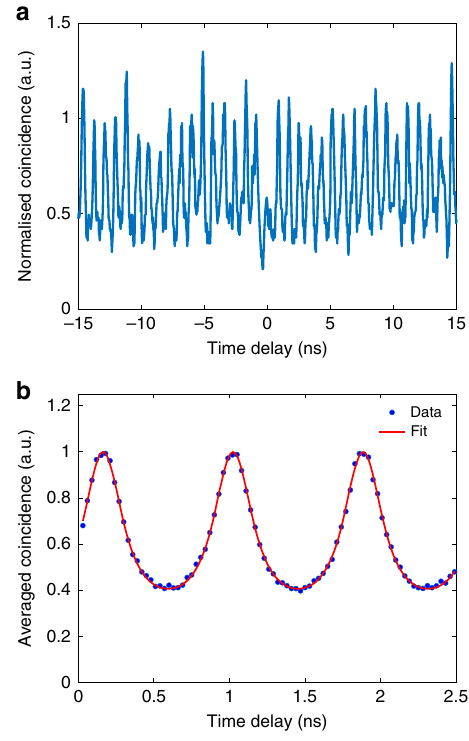
Fig. 3 Photon antibunching in the SAW-driven EL. a Normalised autocorrelation histogram of the SAW-driven EL. The coincidence at Δ t = 0 is suppressed to 58% of the average peak value, indicating photon antibunching, i.e., that there is a reduced probability of two photons arriving simultaneously. b Averaged autocorrelation histogram and the best fi t using G ( Δ t ) (see Supplementary Note